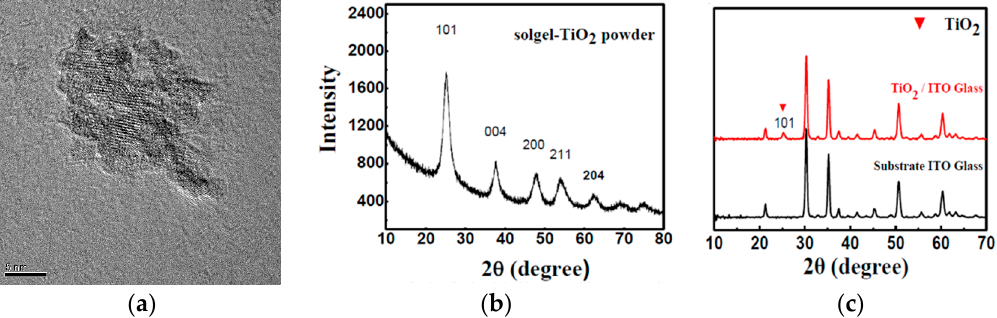
Figure 2. ( a ) Transmission electron microscopy (TEM) image of the TiO 2 nanoparticles dispersed in ethanol at a concentration of 1.0 mg/mL; ( b ) XRD pattern of the TiO 2 powder drying at 135 °C; and ( c ) XRD patterns of ITO-glass with/without the TiO 2 compact layer coated by the ultrasonic spraying.